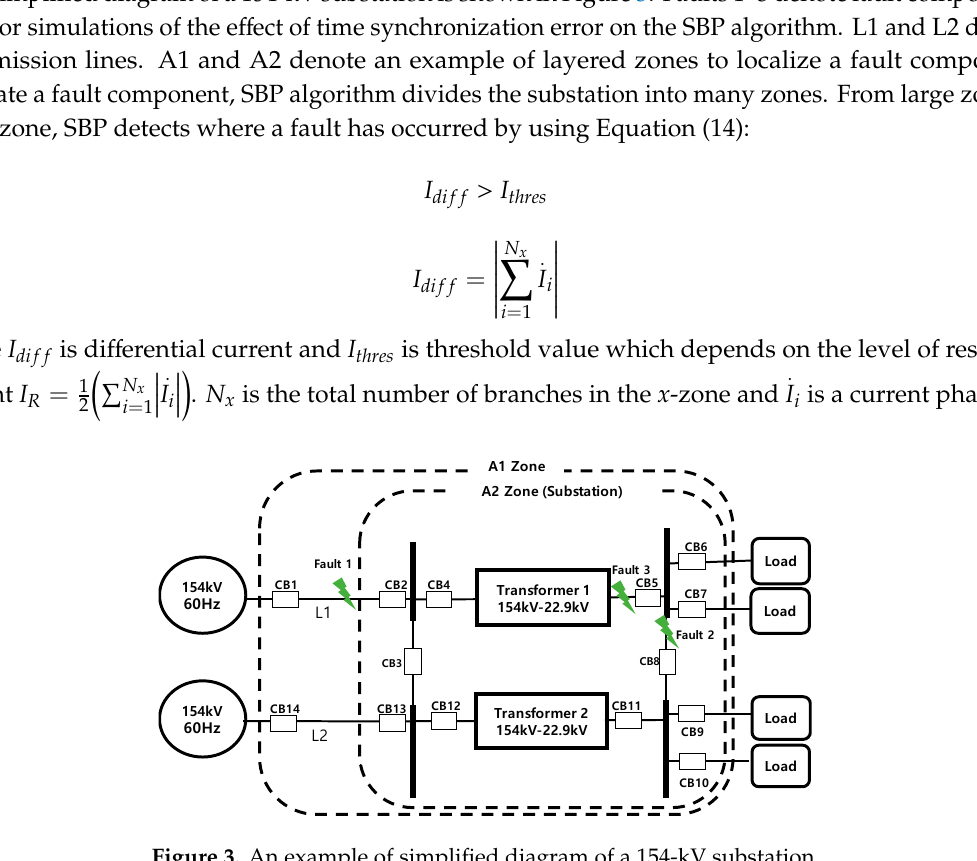
Figure 3. An example of simplified diagram of a 154-kV substation.